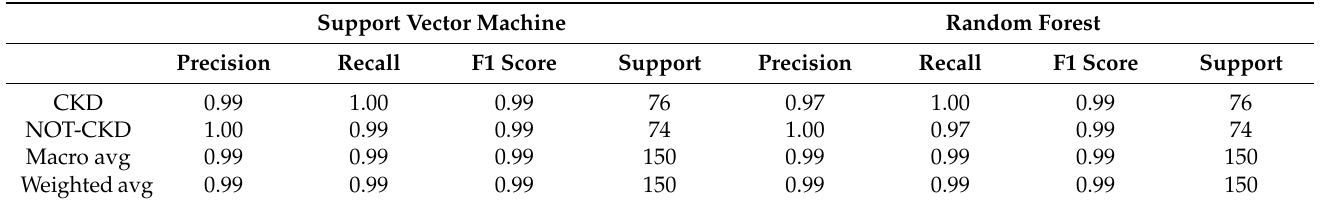
Table 3. Classification report of the trained models, selected features, and their chi-squared scores.